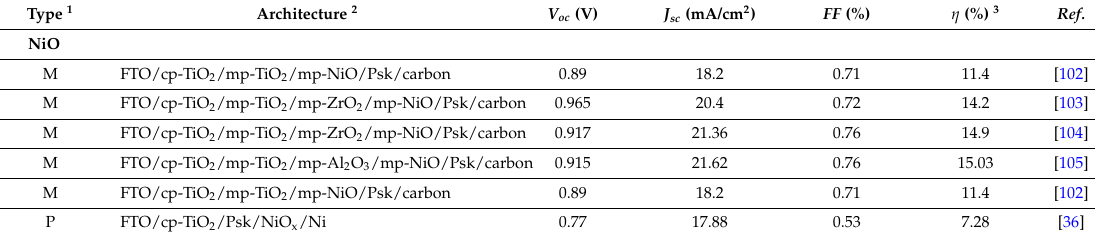
Table 2. Summary of photovoltaic characteristics of organometallic lead halide perovskite solar cell (PSC) based on inorganic hole transport material